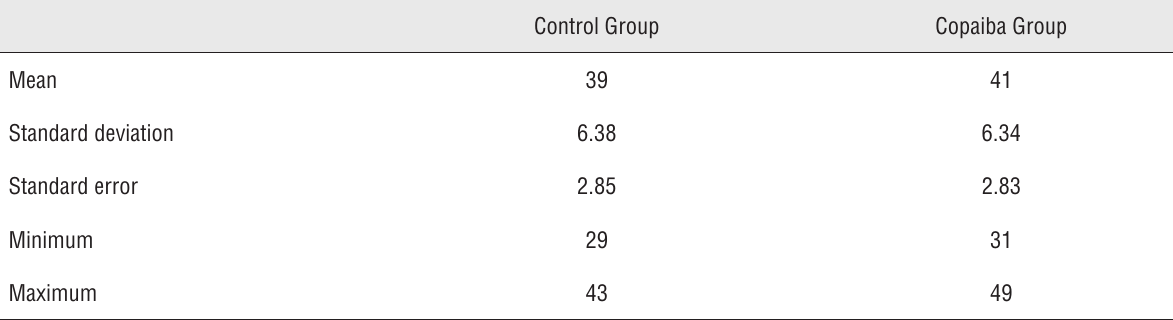
Table 4 - volumetric density in percentage (vv%) of collagen in the bladder of control and copaiba groups. Control